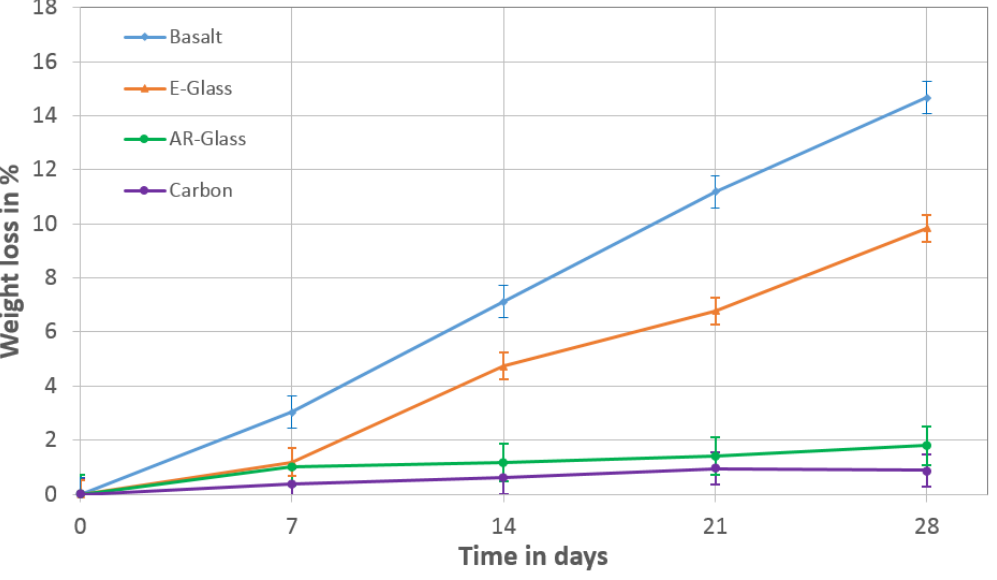
Figure 4. Weight losses of the fibers due to the alkaline attack.